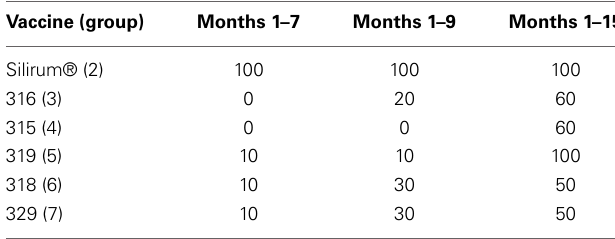
Table 6 | Sensitivity (%) of the Parachek (cid:2) ELISA, by vaccine. The cutoff value was set at ELISA_OD =